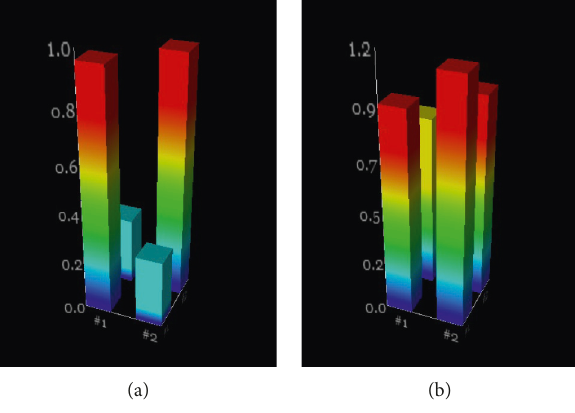
Figure 15: (a) Modal assurance criterion (MAC); (b) modal scale factor (MSF). Table 5: Parameters relating to the modal